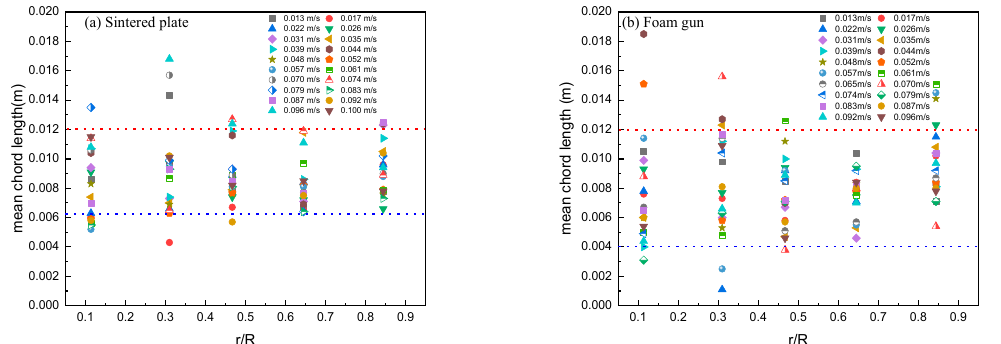
Figure 8. Mean chord length measured at di ff erent radial positions when using di ff erent generation